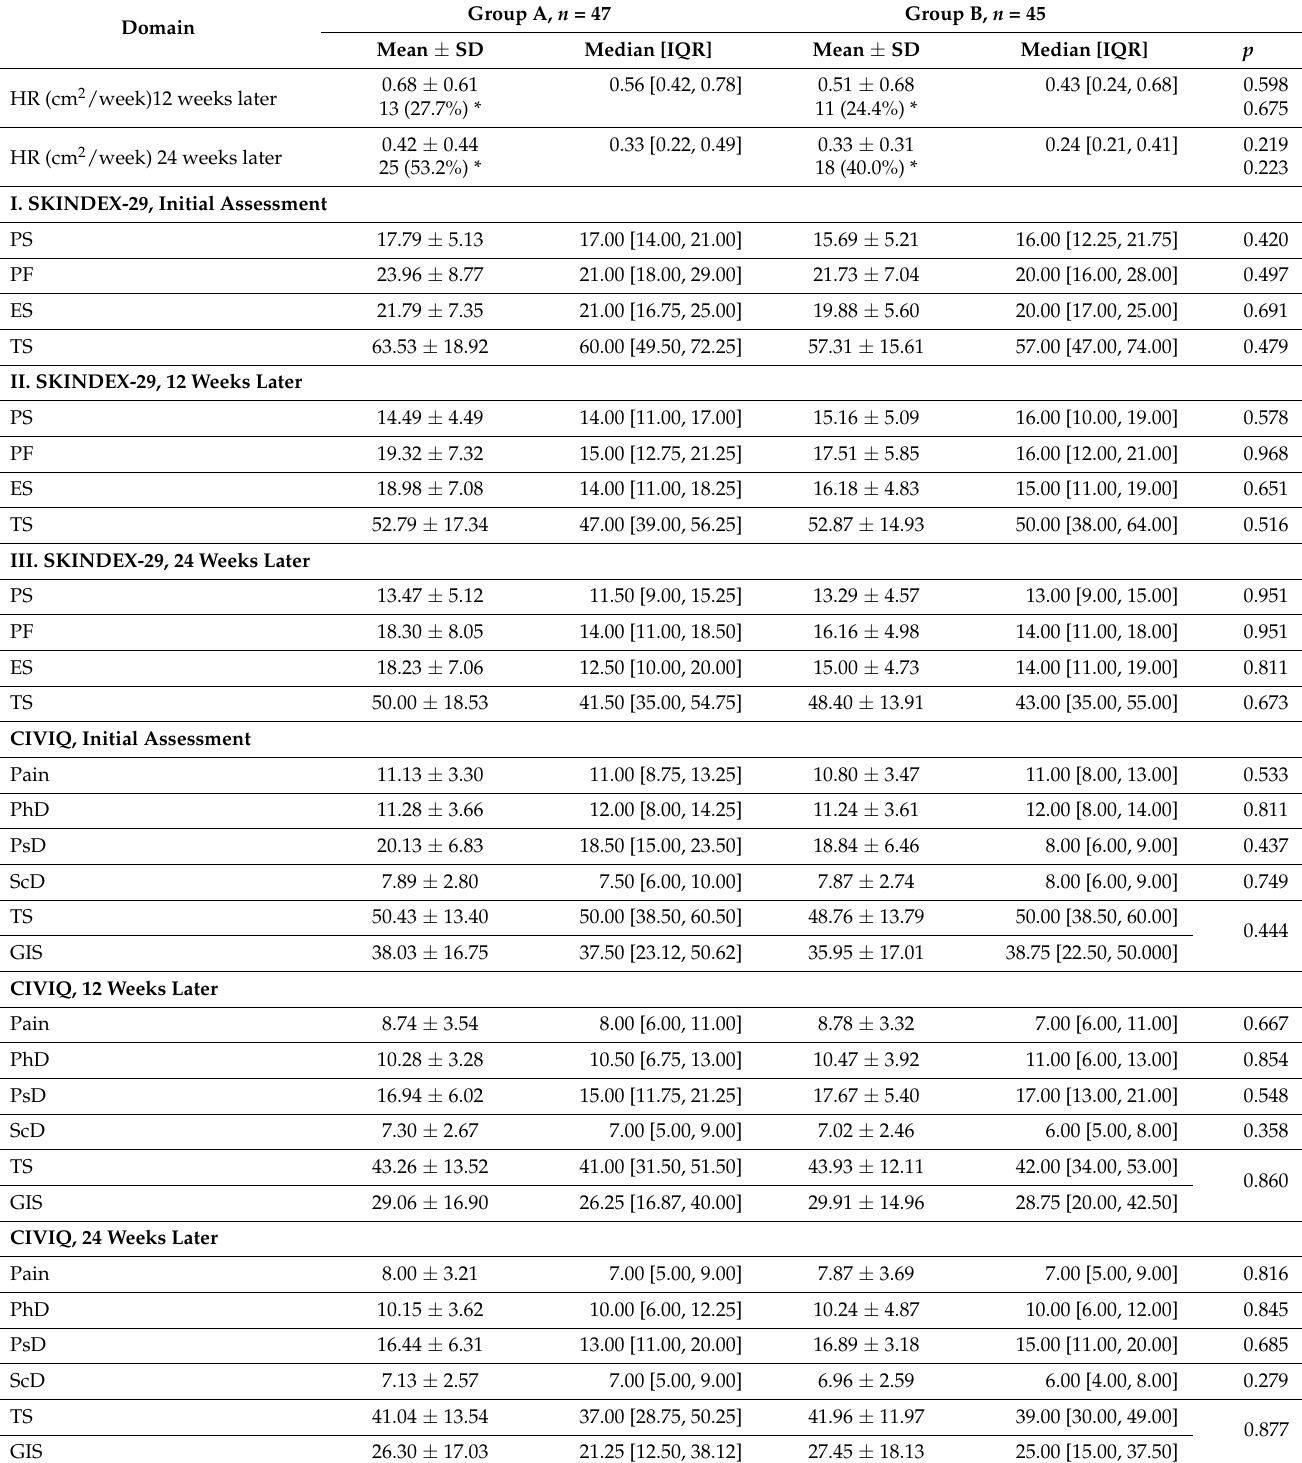
Table 2. Comparison of the quality of life and the ulcer healing process in the studied